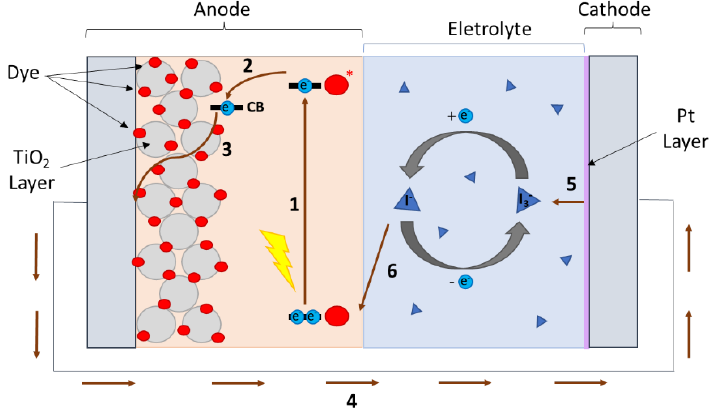
Figure 1. Schematic representation of the operating principles of a DSSC device.